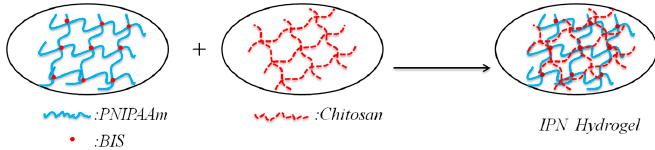
Figure 1. Synthesis scheme of the IPN hydrogel.